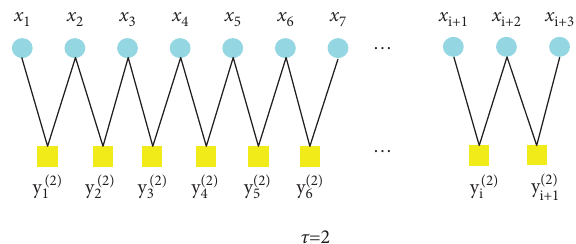
Figure 2: Improved coarse-grained procedure with scale factor of